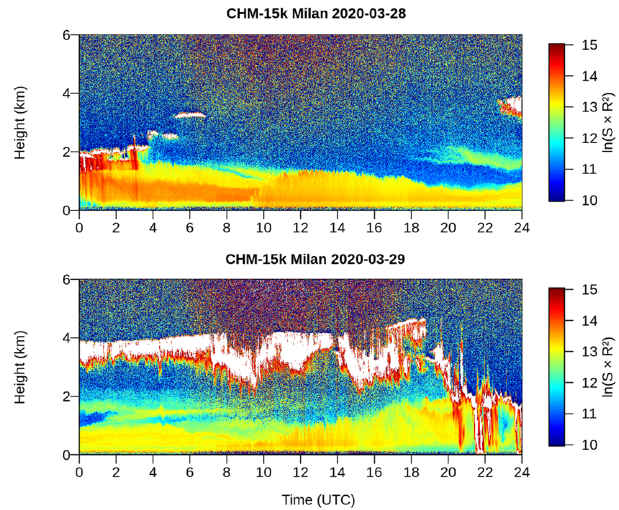
Figure 9. Vertical profiling from the automated lidar ceilometer lo- cated in Milan on 28 and 29 March